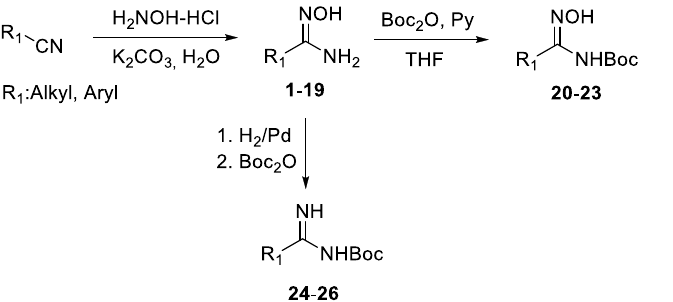
Scheme 1. Synthesis of the studied compounds 1 – 26 .